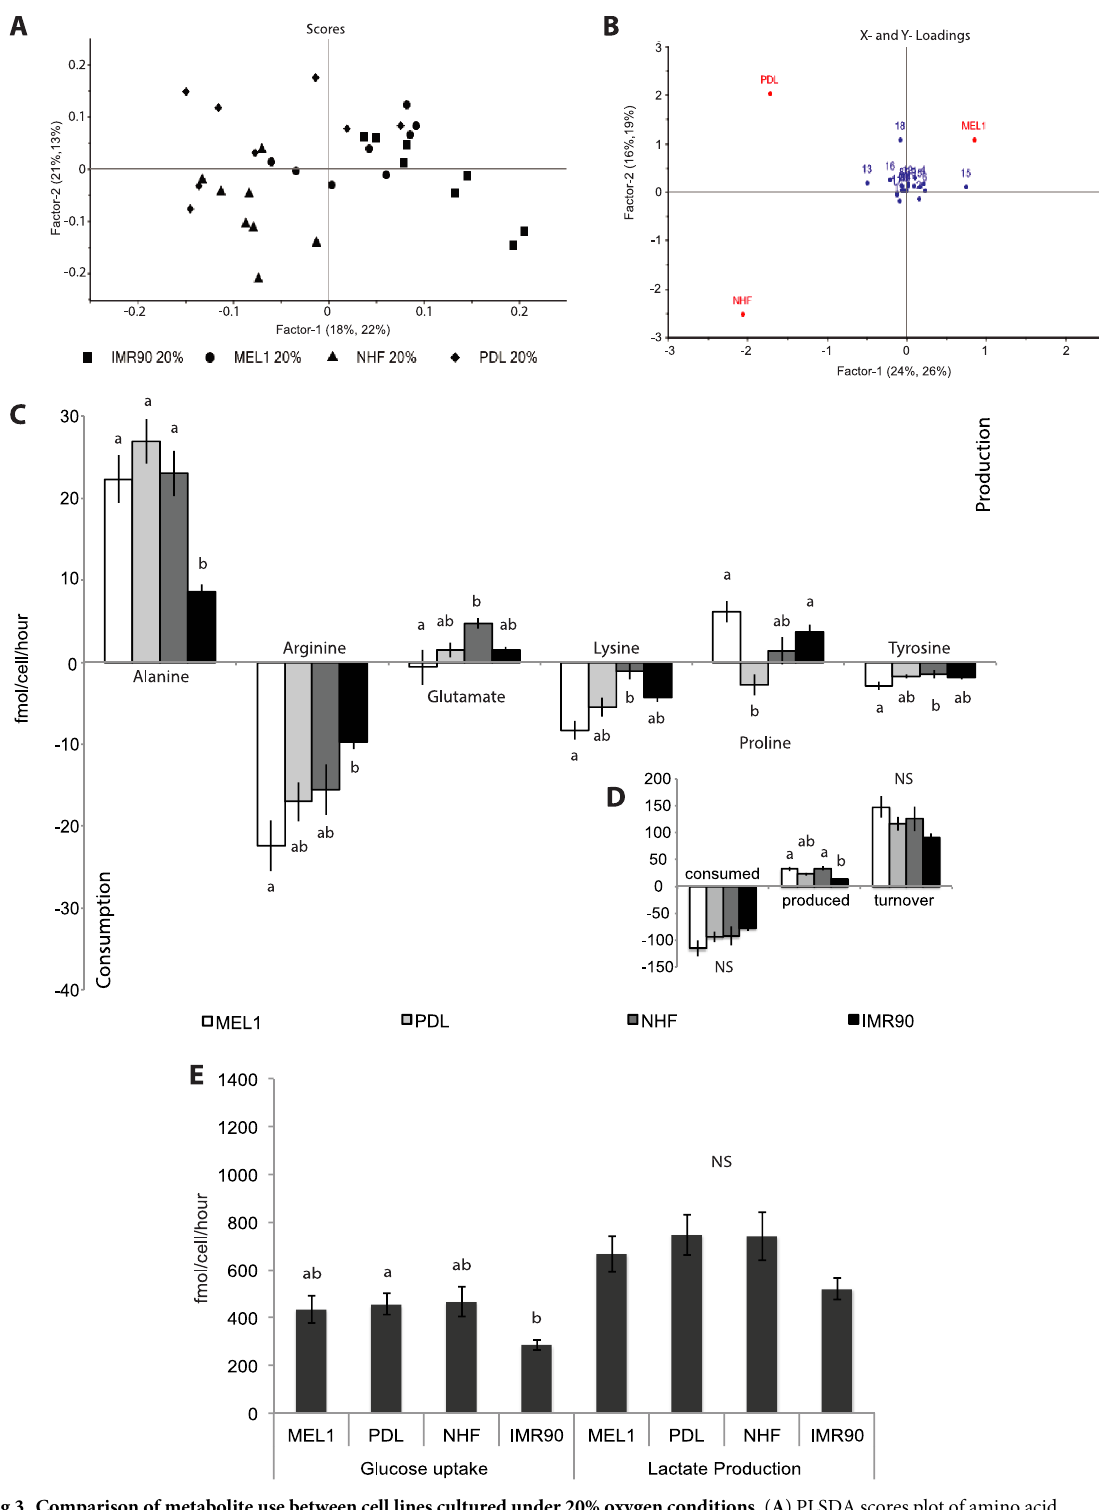
Fig 3. Comparison of metabolite use between cell lines cultured under 20% oxygen conditions. ( A ) PLSDA scores plot of amino acid concentrations of human embryonic and iPS cells cultured in mTeSR medium under 20% oxygen. ( B ) PLSDA loadings plot of amino acid concentrations of human embryonic and iPS cells cultured in mTeSR medium under 20% oxygen. ( C ) Significant differences in amino acid utilisation, ( D ) total amino acid consumption, production and turnover, and ( E ) glucose uptake and lactate production between MEL1 human ES,